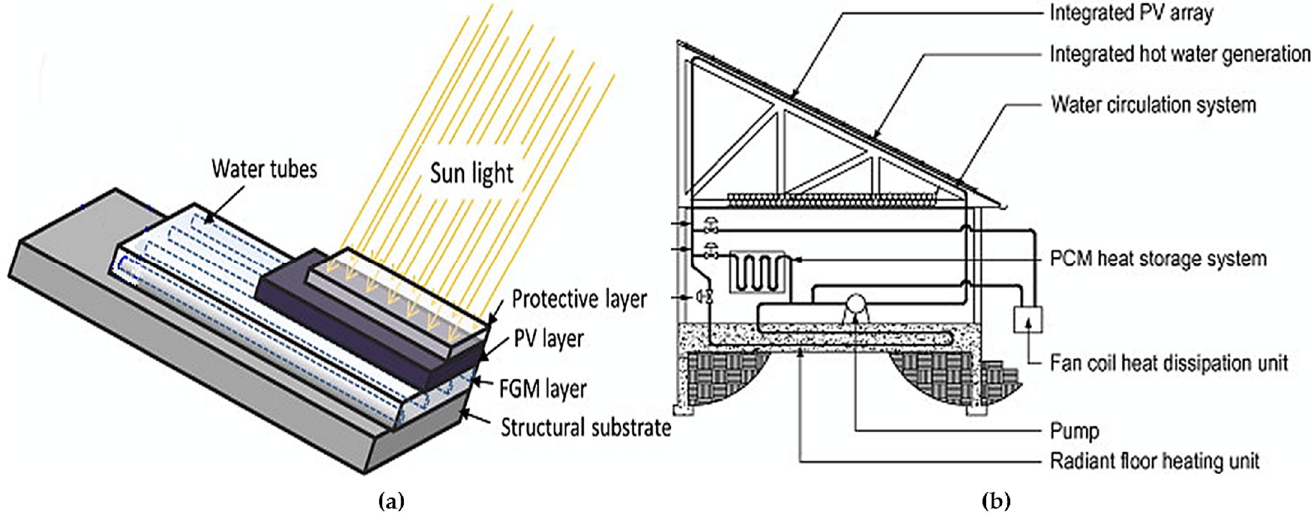
Figure 3. ( a ) The illustration of proposed BIPVT on roofing panel and ( b ) BIPVT cross-section. Adapted with permission from ref. [66]. 2013. Yin et al.